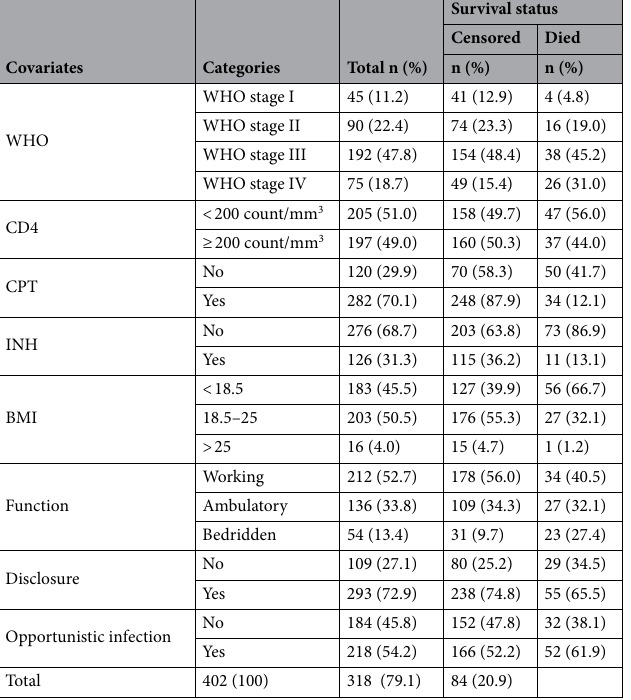
Table 2. Summaries of clinical features of TB and HIV co-infected adults on ART at Mettu Karl Referral Hospital, Ethiopia, 2014–2022 (n = 402).